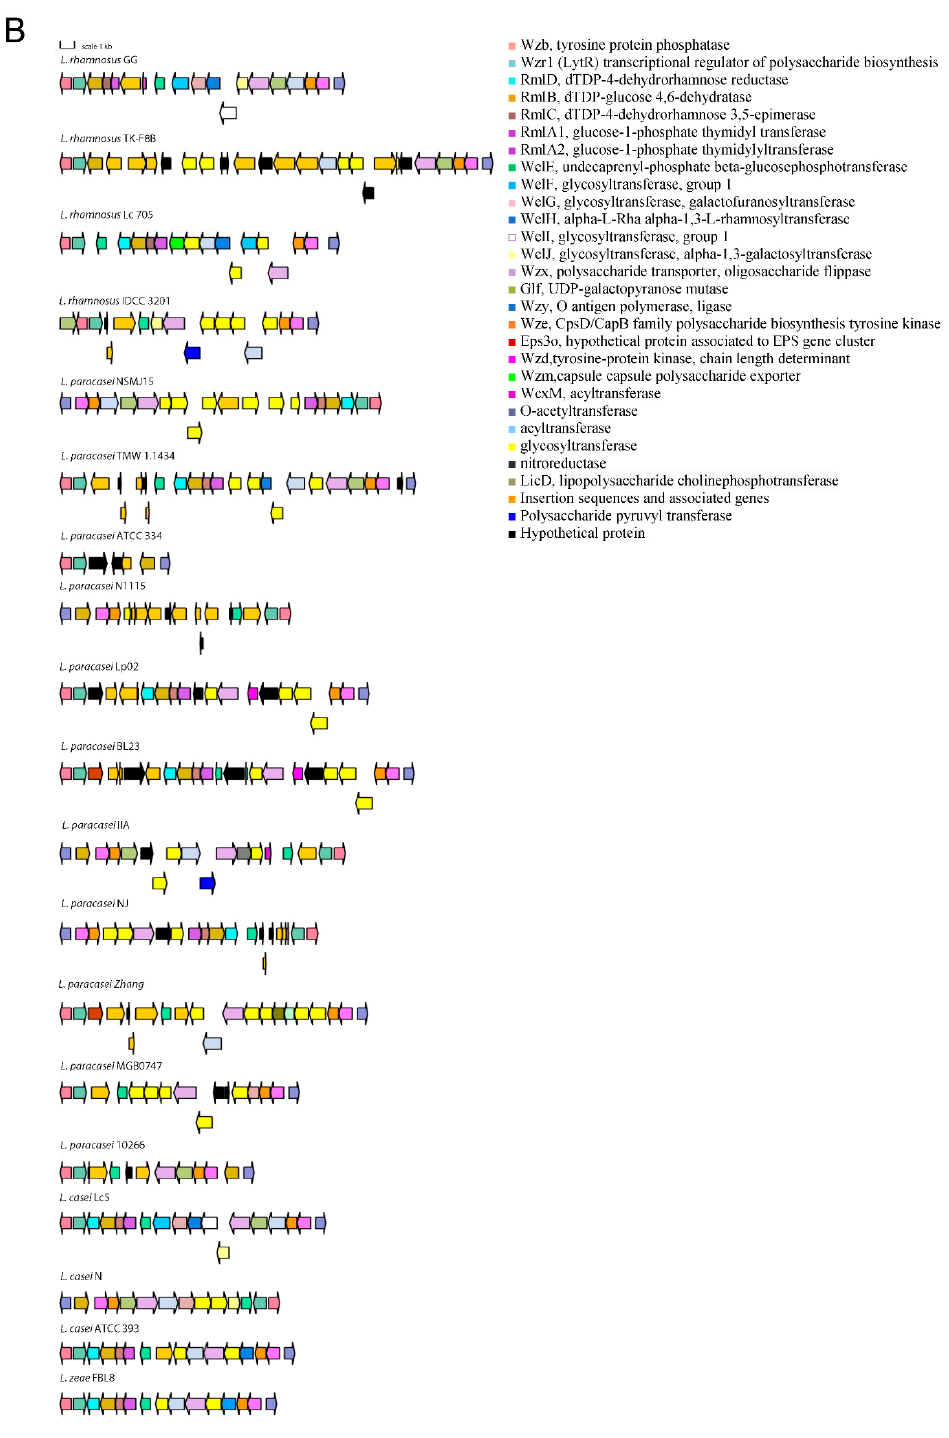
Figure 1. Gene arrangement in the EPS production gene clusters starting from proteins orthologous to LGG_01990 ( A ) and LGG_02036 ( B